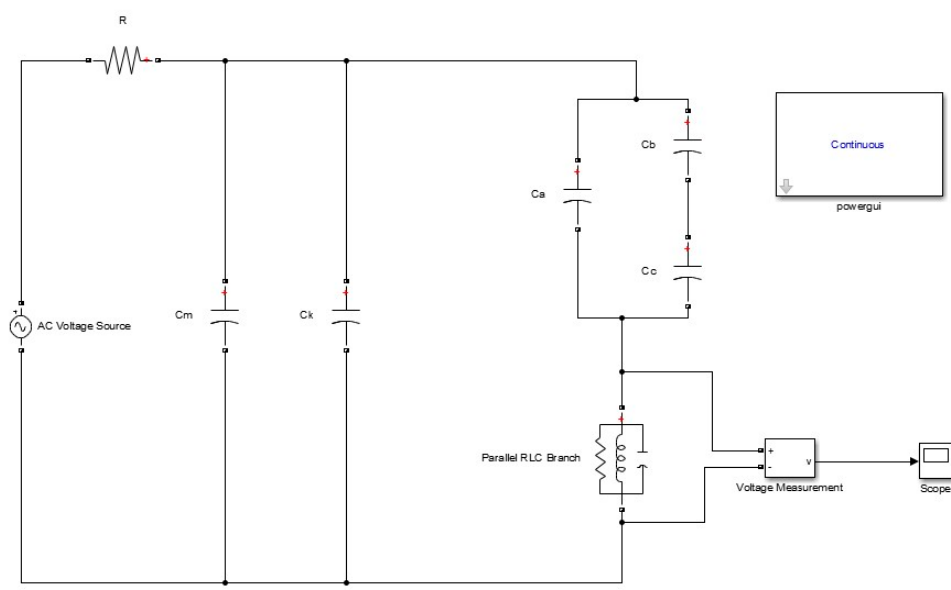
Table 4. Capacitive Model’s Parameters (2 h, r).